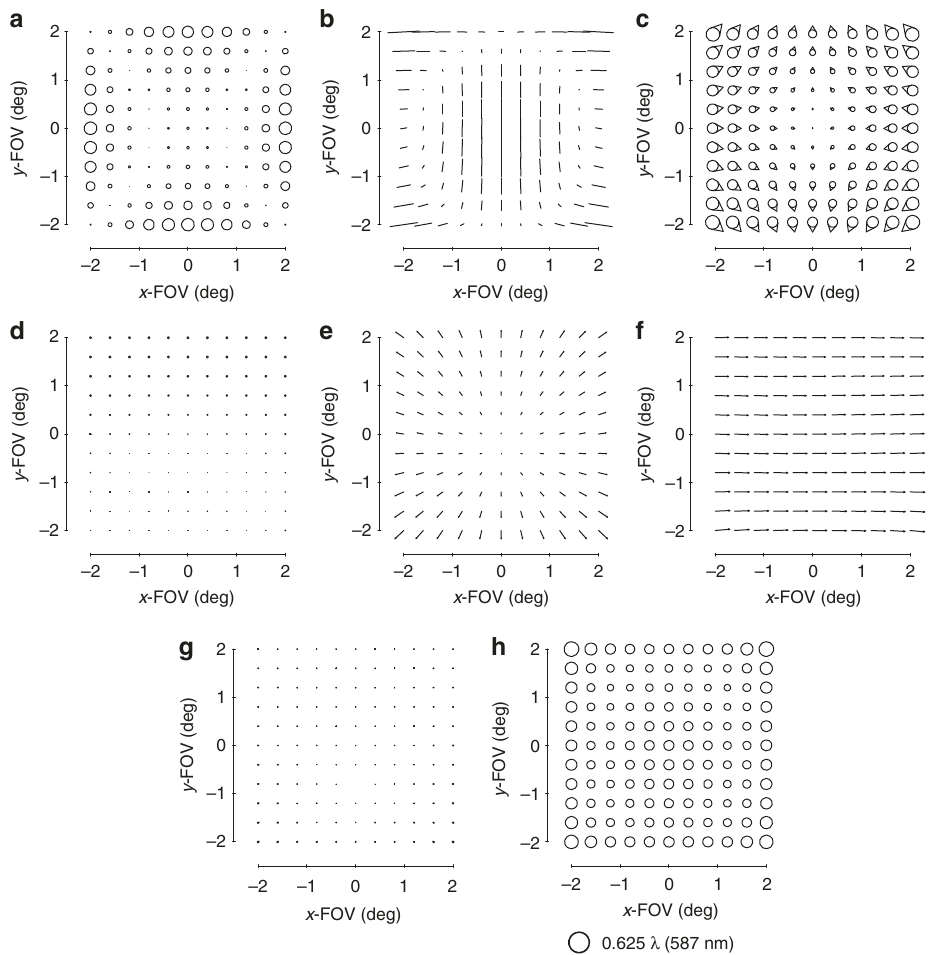
Fig. 7 Zernike-based aberration FFDs after a fi fth-order aperture coma surface. After adding a fi fth-order aperture coma shape to all three mirrors and then reoptimizing the form of the geometry, the aberrations of the system were calculated and are shown in full- fi eld displays (FFDs for a defocus (Z4), b astigmatism (Z5/6), c coma (Z7/8), d spherical aberration (Z9), e elliptical coma (Z10/11), f oblique spherical aberration (Z12/13), g fi fth-order aperture coma (Z14/15), and h root-mean-square wavefront error (RMS WFE. Note the scale decreased 2× from Fig.